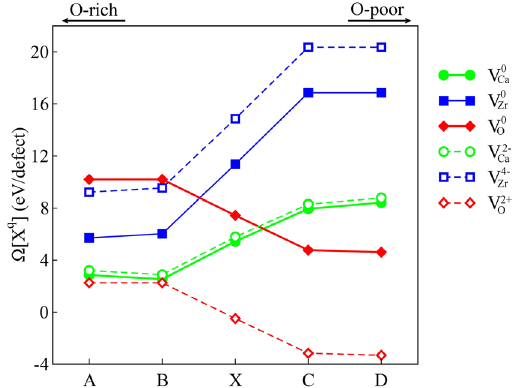
Figure 6. The calculated formation energies (eV/defect) of V Caq , V Zrq and V Oq vacancies in CaZrO 3 at stability coordinates defined in Fig.